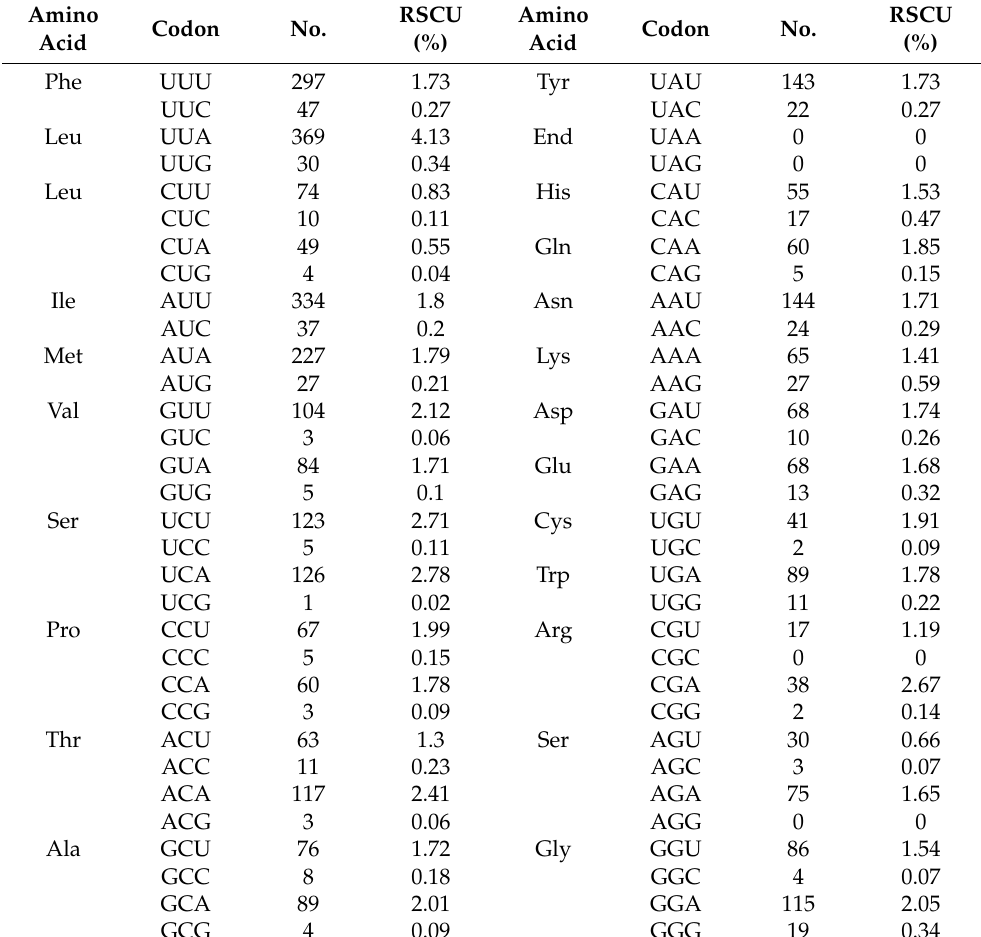
Table 4. Codon usage of the PCGs of Alulacrisshilinensis